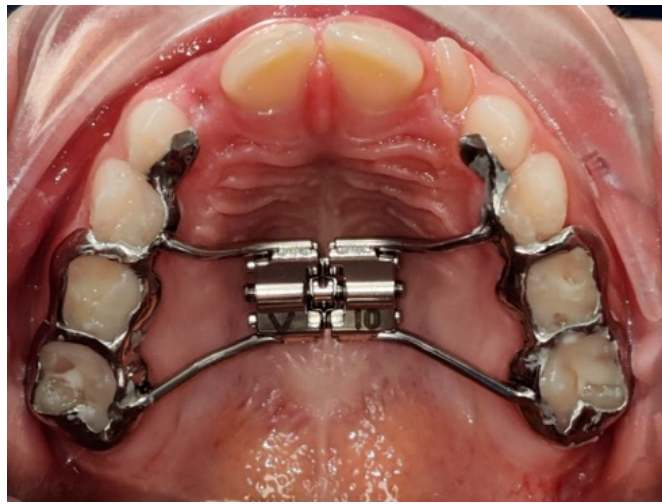
Figure 4. Clinical image of a cemented RPE.